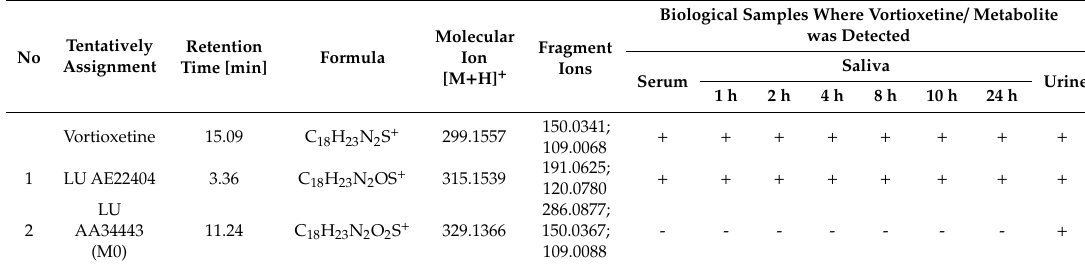
Table 5. Retention time, formula, molecular ion, fragment ion for vortioxetine and its metabolites, biological samples where vortioxetine / metabolites were detected.